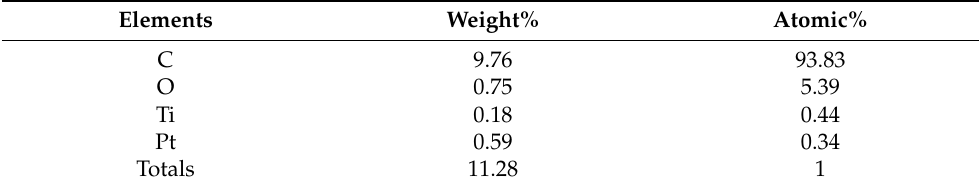
Table 1. Content of elements in Pt/Ti 3 C 2 T x